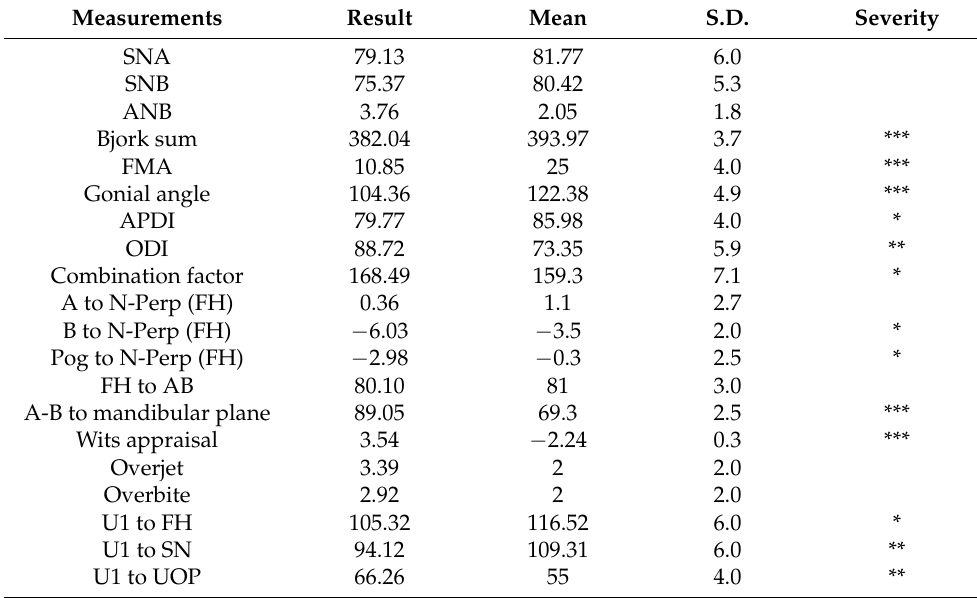
Table 2. Post-treatment cephalometric values of case number